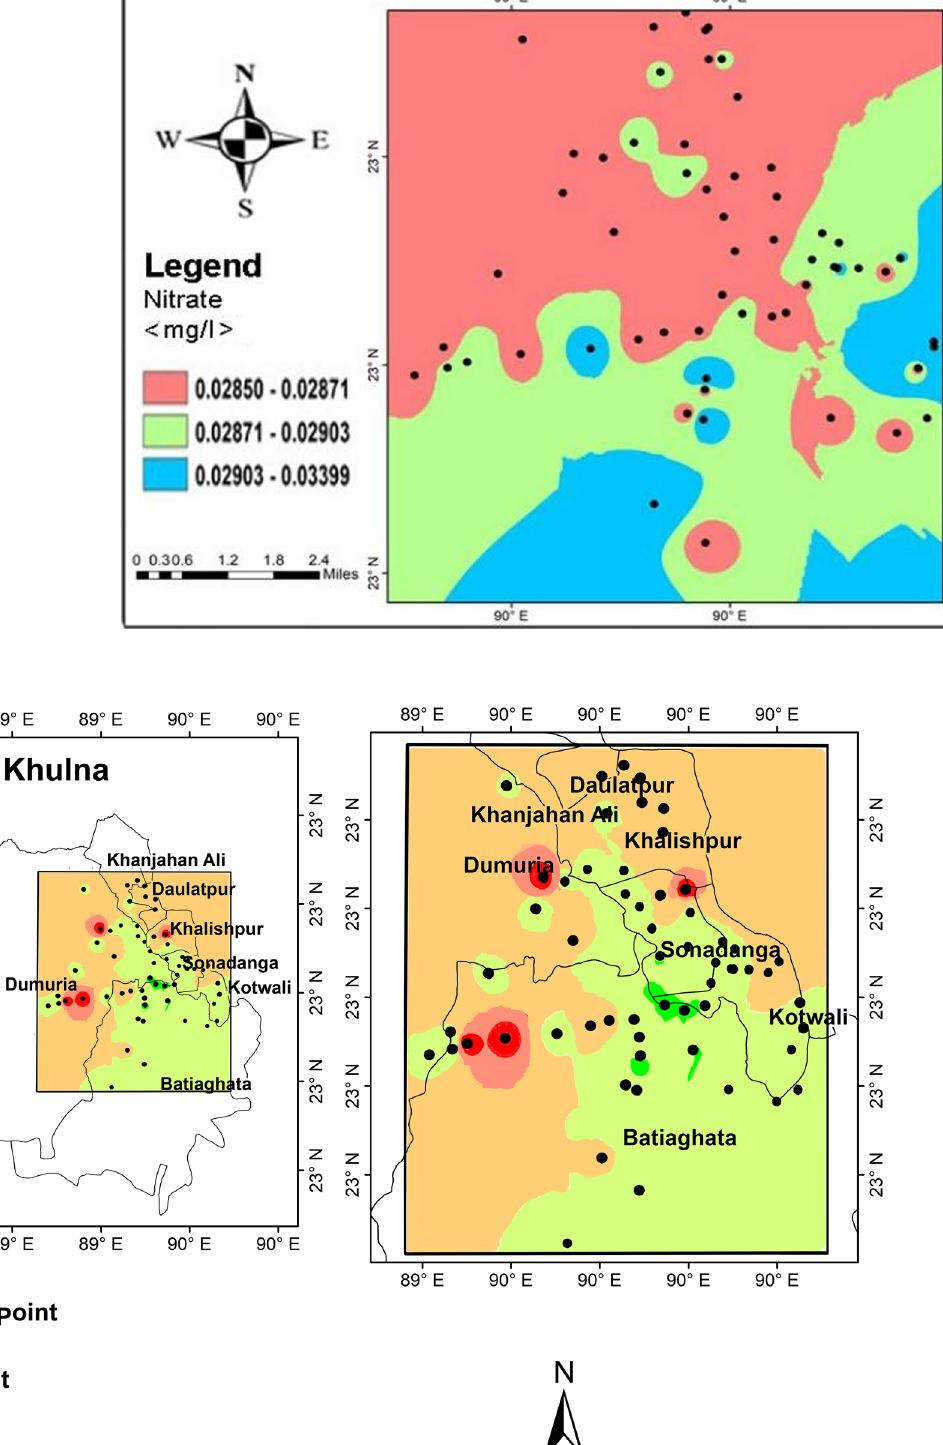
Fig. 9 Spatial distribution of nitrate in selected tube wells water